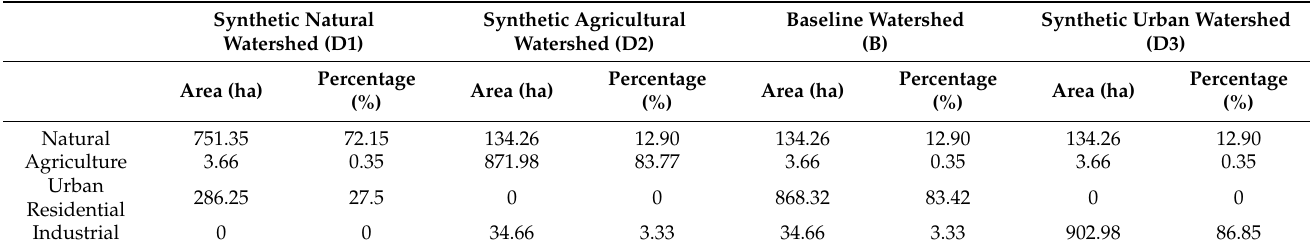
Figure 3. Land cover for three synthetic watersheds from the original baseline watershed: ( a ) synthetic natural watershed (D1); ( b ) synthetic agricultural watershed (D2); ( c ) original Watts Branch watershed (B) as the baseline watershed; ( d ) synthetic urban watershed (D3). Table 2. Land cover for three synthetic watersheds.